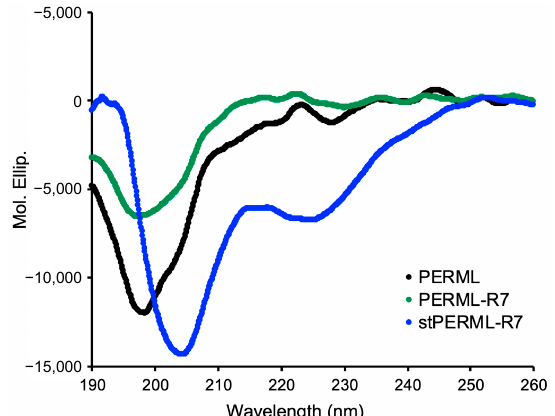
Figure 3. CD spectra of PERML, PERM-R7 and stPERML-R7 in 20 mM phosphate buffer (pH = 7.4). Peptide concentration = 50 μ M.